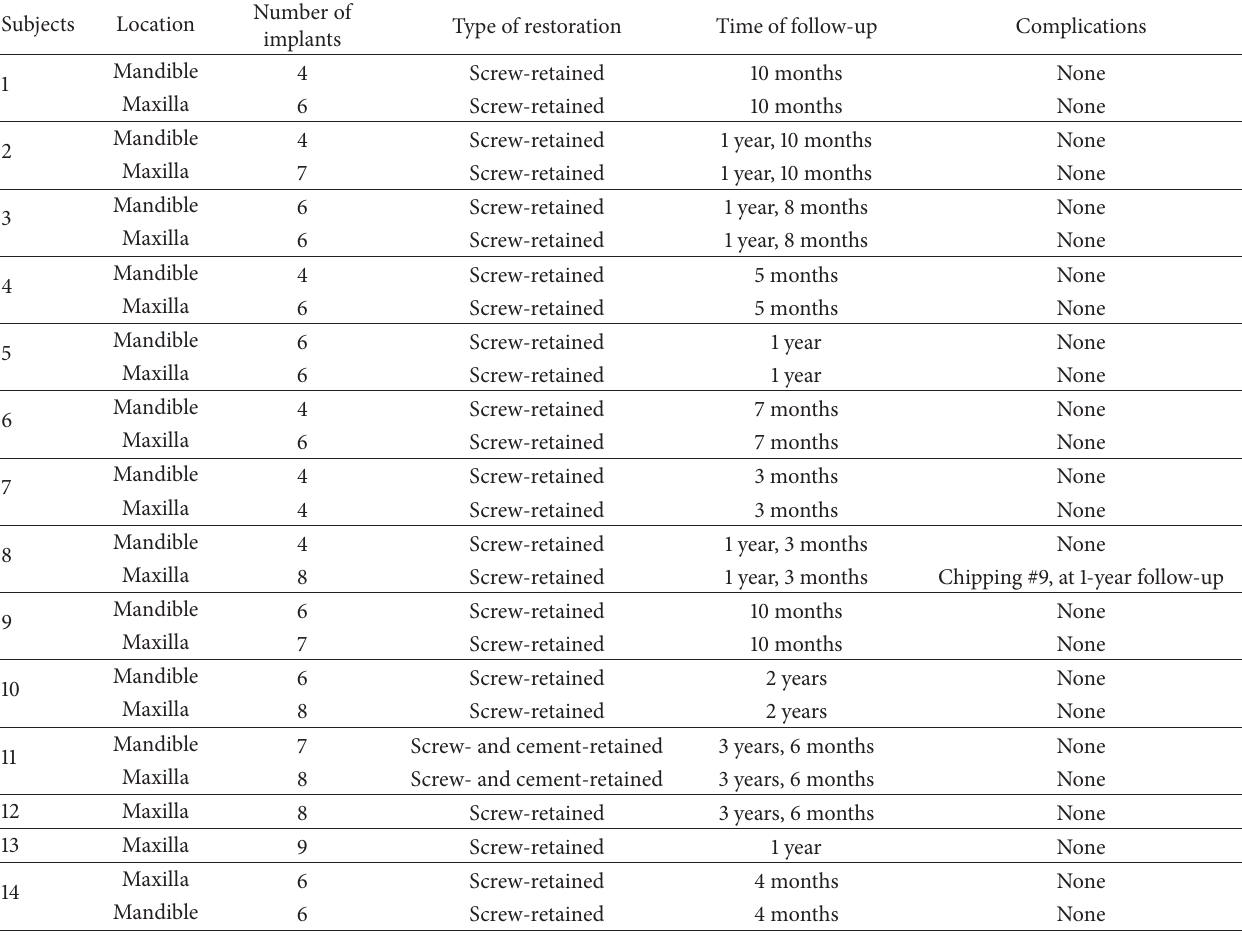
Table 2: Results of 14 cases in which monolithic zirconia framework for full arch implant supported reconstruction was used. Subjects